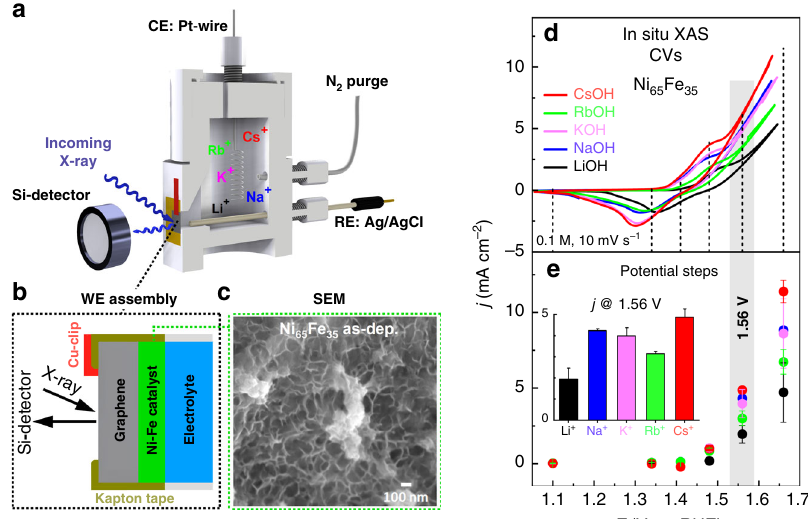
Fig. 1 Electrochemical cell setup and OER activity during in situ XAS. a Schematic drawing of the cell used for the in situ XAS investigations of the Ni 65 Fe 35 (OOH) catalyst, carried out in puri fi ed 0.1 M LiOH, NaOH, KOH, RbOH, and CsOH. The cell body was made of PTFE/PEEK ( ø = 50 mm, with a 6 × 6 mm X-ray transparent window), a leak-free Ag/AgCl reference electrode, and a Pt-mesh as counter electrode. b Enlargement of the working electrode showing the ~300 nm thick Ni 65 Fe 35 fi lm electrodeposited on a ~35 µ m thick graphene-sheet as working electrode. c SEM image of the as-deposited Ni 65 Fe 35 fi lm on the graphene electrode. d CVs at 10 mV s − 1 during the in situ XAS measurements at the P64 beamline at Petra III (DESY). e Potential steps during collection of the Ni and Fe K -edges, where the inset shows a trend plot of current density ( j ) at 1.56 V against the electrolyte cation. All potentials have been converted from the Ag/AgCl to the RHE potential scale. Error bars represent the standard error from the overall number of